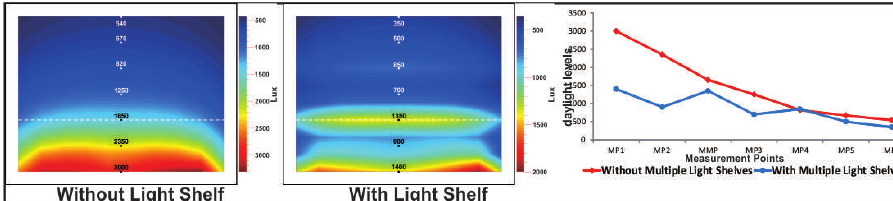
Fig. 12. Comparison of light distribution at 12